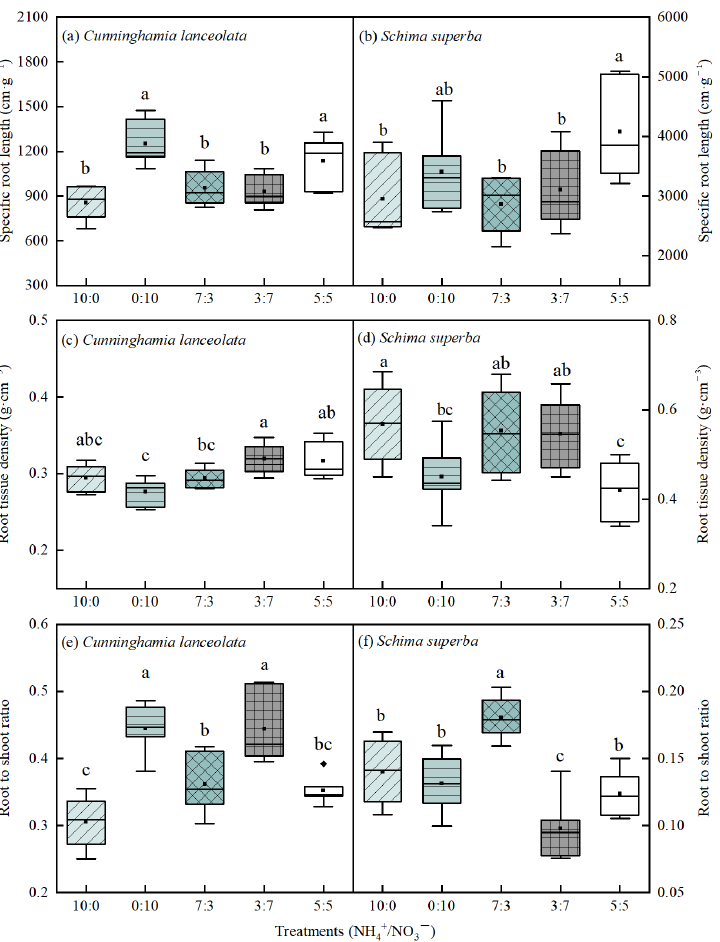
Figure 3. Effects of different NH 4+ -N and NO 3 − -N ratios on SRL ( a , b ), RTD ( c , d ) and RSR ( e , f ) between the two tree species. Different lowercase letters indicate that the SRL, RTD and RSR were significantly different under different N forms ( p < 0.05).